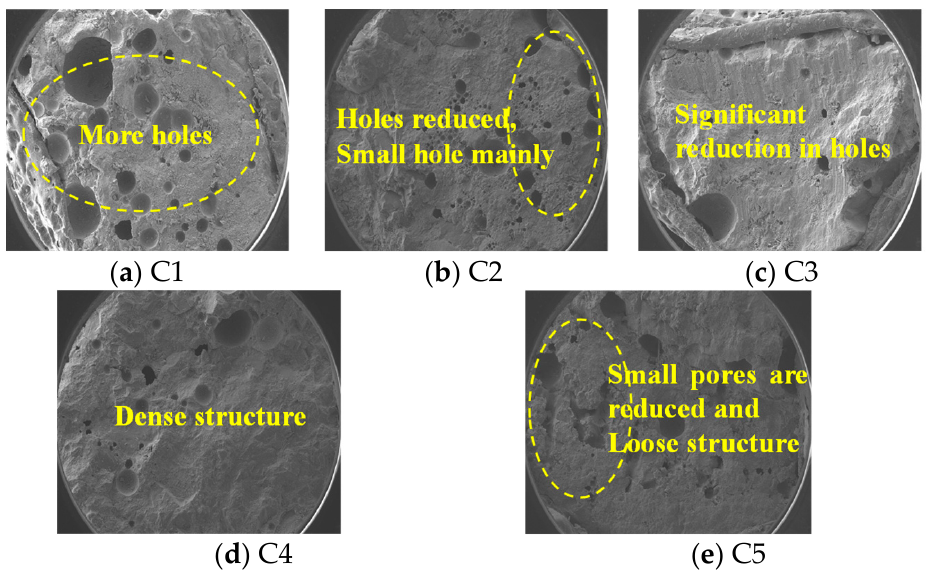
Figure 3. Concrete pore structure changes after corrosion.